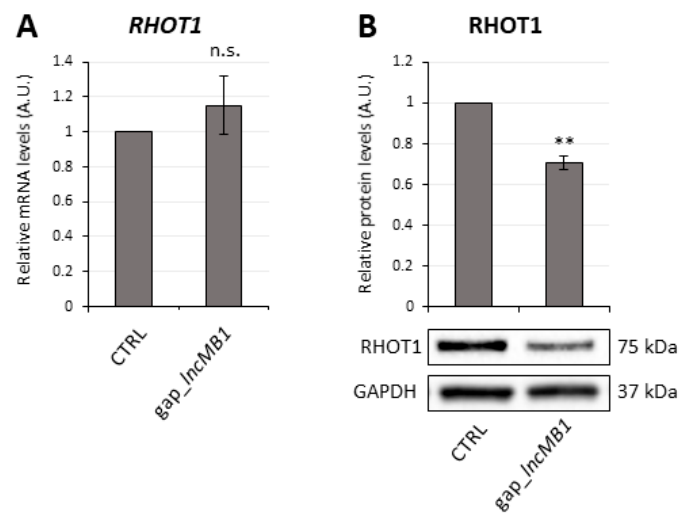
Figure 12. LncMB1 controls RHOT1 protein levels in DOX-untreated D283 MED cells. ( A ) qRT- PCR analysis of RHOT1 expression in DOX-untreated D283-OMO cells upon depletion of lncMB1 , compared to scramble-transfected cells, set as 1. Data (means ± SEM) are expressed in arbitrary units (A.U.) and are relative to ATP5O mRNA. N = 4 (two-tailed Student’s t -test). ( B ) Representative immunoblot analysis of RHOT1 protein levels in DOX-untreated D283-OMO cells upon lncMB1 knock-down, compared to scramble-transfected cells. In the histogram above, RHOT1 protein levels were quantified, relative to GAPDH. RHOT1 level in scramble-transfected cells, used as control, was set as 1. Data (means ± SEM) are expressed in arbitrary units (A.U.). N = 4, ** p ≤ 0.01 (two-tailed Student’s t -test).